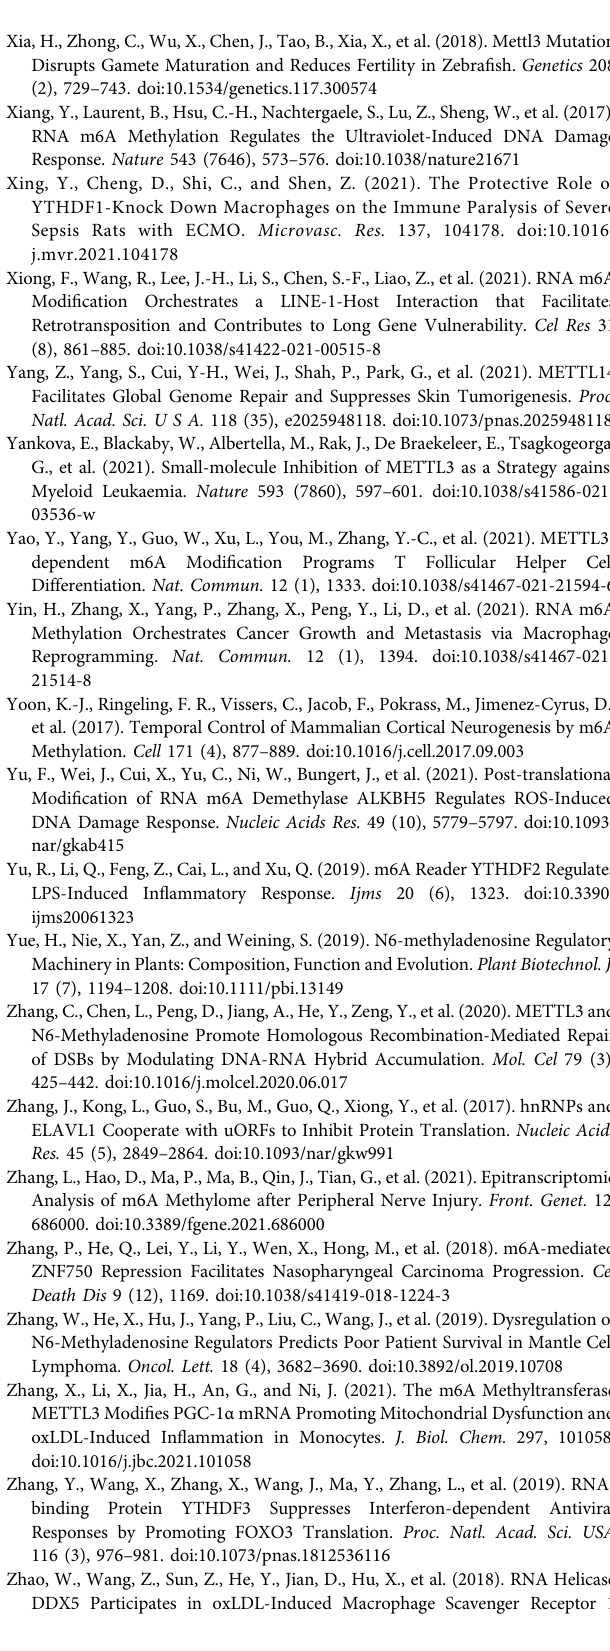
Frontiers in Cell and Developmental Biology |